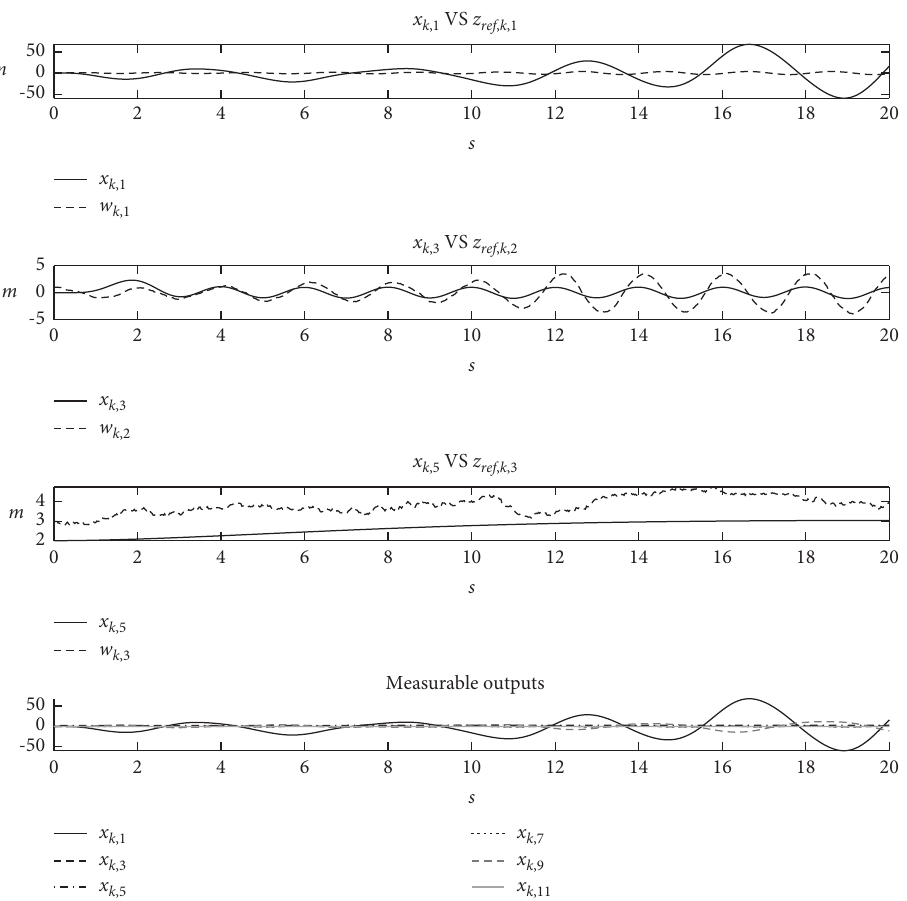
Figure 8: Tracking random references considering the structure